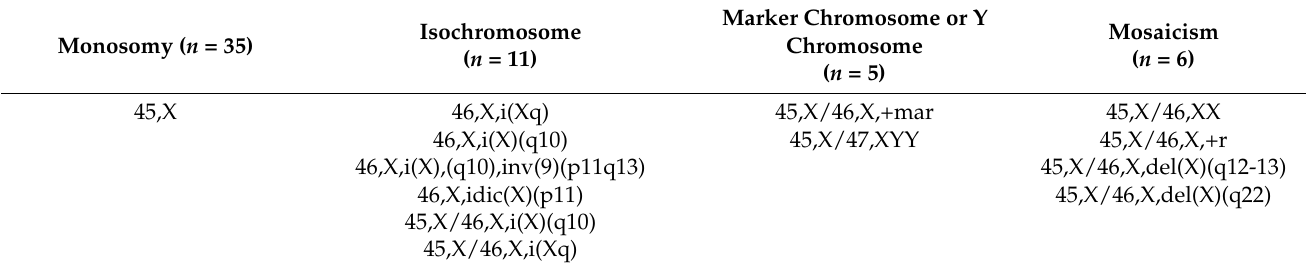
Table 1. Karyotypes abnormalities in patients with